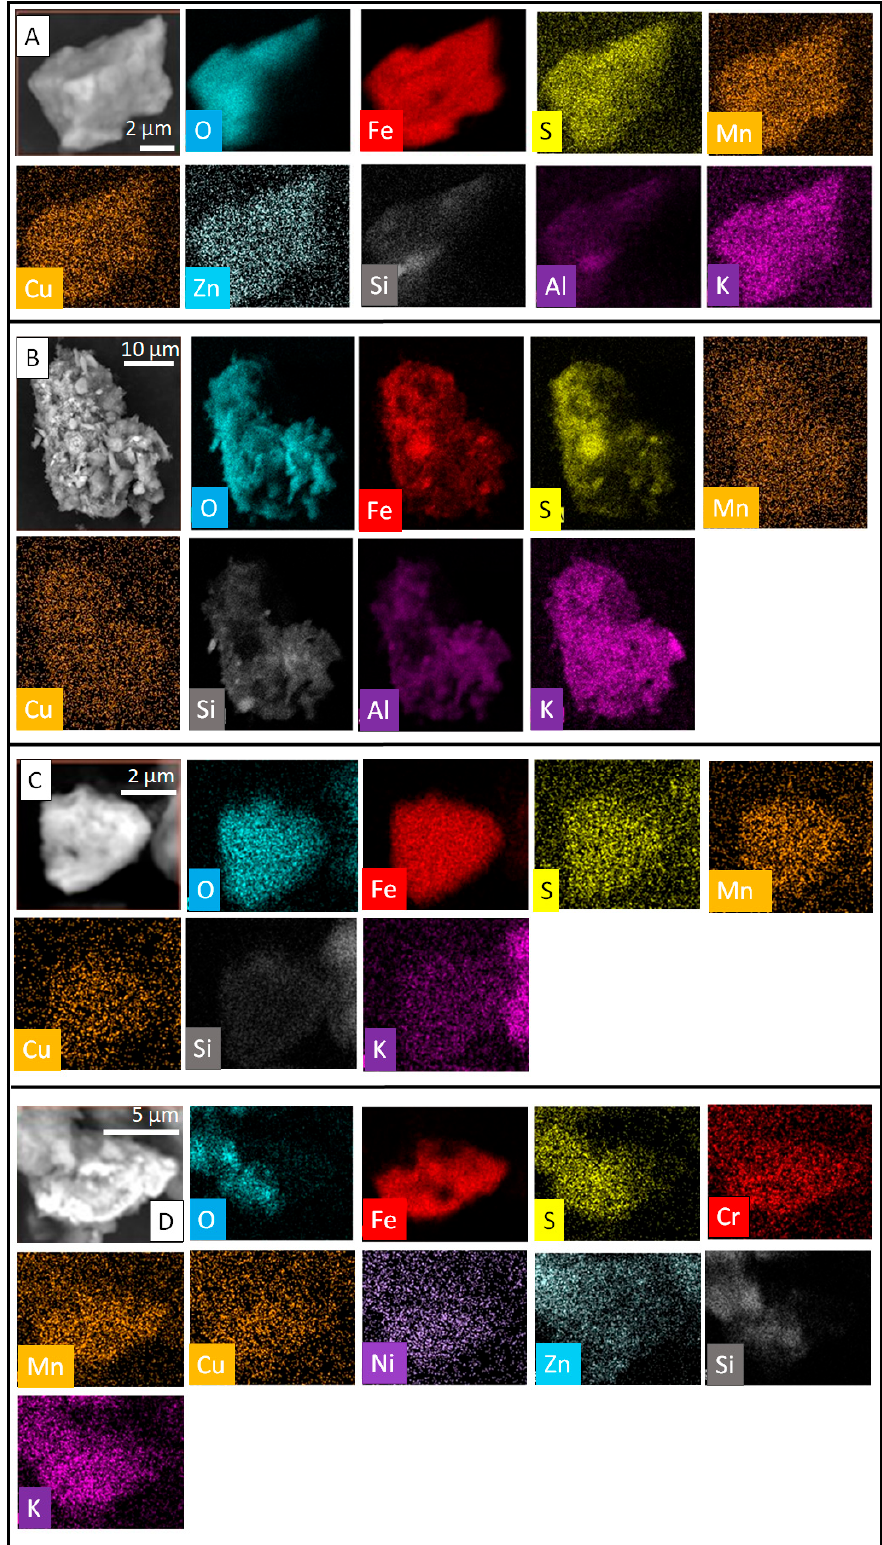
Figure 4. ( A – D ) Representative Fe(III)-oxyhydroxysulfates colloids collected from bulk soils developing on historic mine spoil and collected from spoil piles 2 ( A , B ), 9 ( C ), and 10 ( D ).